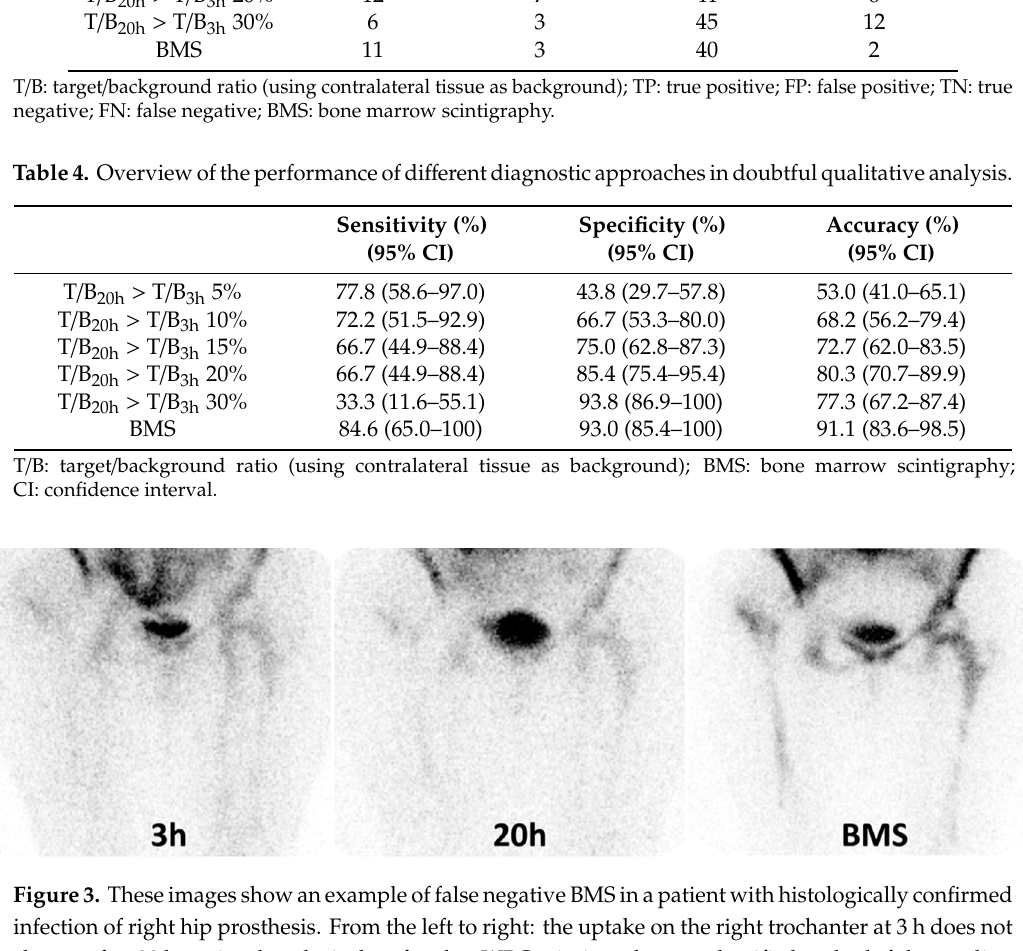
Table 5. Comparison between different thresholds of semi-quantitative analysis and BMS according to final diagnosis in terms of p values.